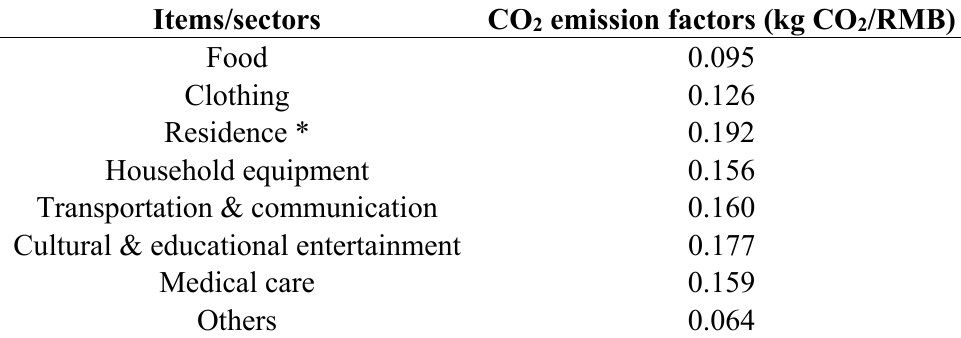
Table 2. CO 2 emission factors for different types of goods and